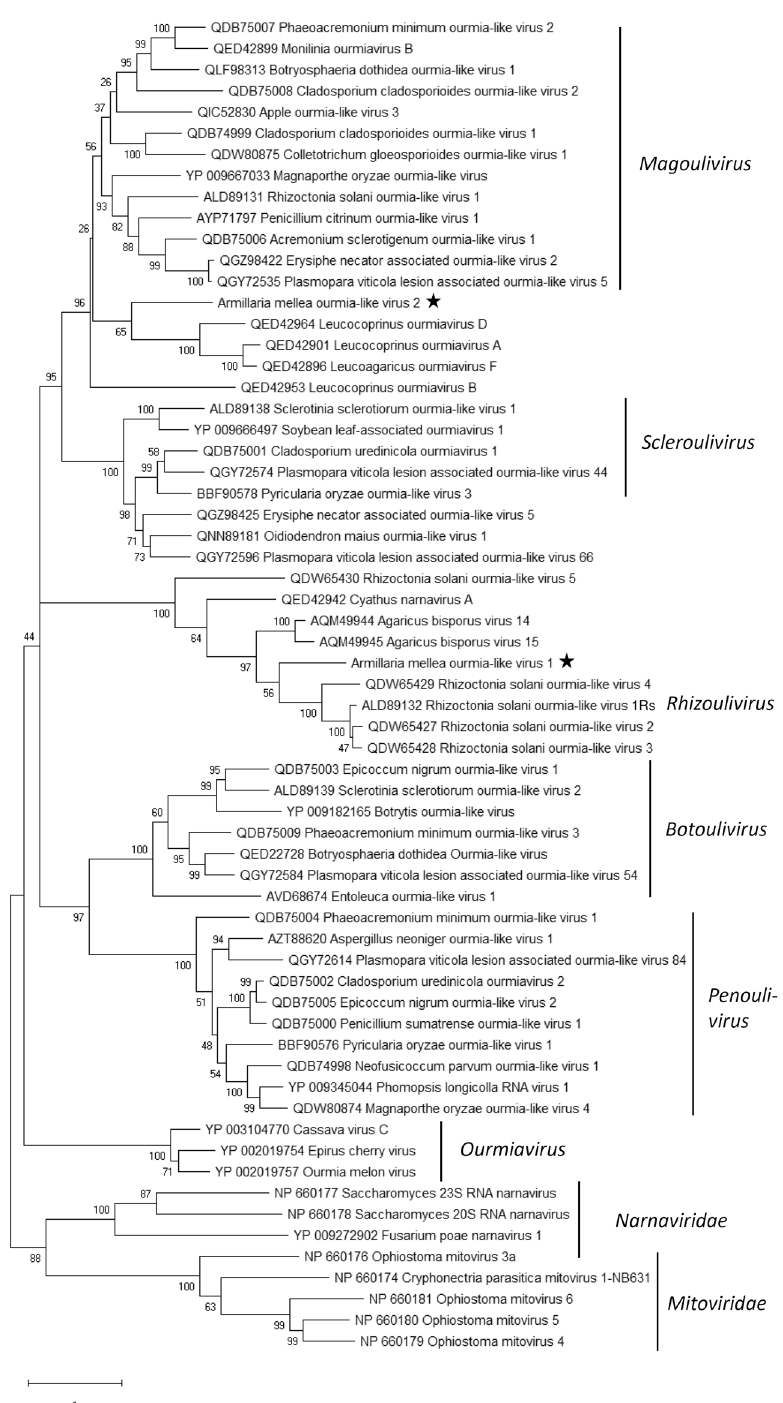
Figure 5. Phylogenetic tree of the family Botourmiaviridae and selected related families based on an alignment of RdRP aa sequences generated using MAFFT v7.450 with Blosum62 substitution matrix. The evolutionary history was inferred by using the Maximum Likelihood method and Le_Gascuel_2008 model with 4 gamma categories (+ G + I ). All positions with less than 95% site coverage were eliminated, i.e., fewer than 5% alignment gaps, missing data, and ambiguous bases were allowed at any position (partial deletion option). Evolutionary analyses were conducted in MEGA X with 1000 bootstrap repeats 86 . The Armillaria viruses are designated with a